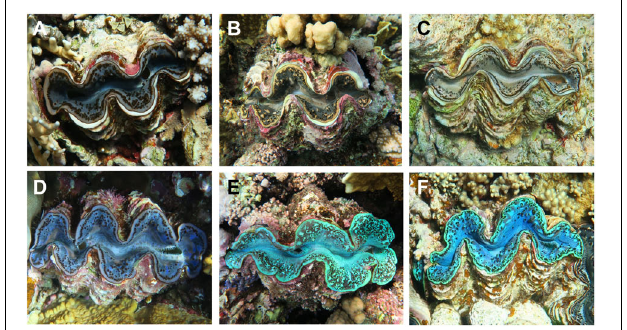
FIGURE 1 | Variations of mantle tissue colorations in Tridacninae, here exemplarily shown for Tridacna maxima . Specimens in the top row (A–C) are examples for brown color variants and those in the bottom (D–F) for blue appearing mantle colorations. Panels (C,F) , respectively, are equivalents for the brown and blue variation used in this